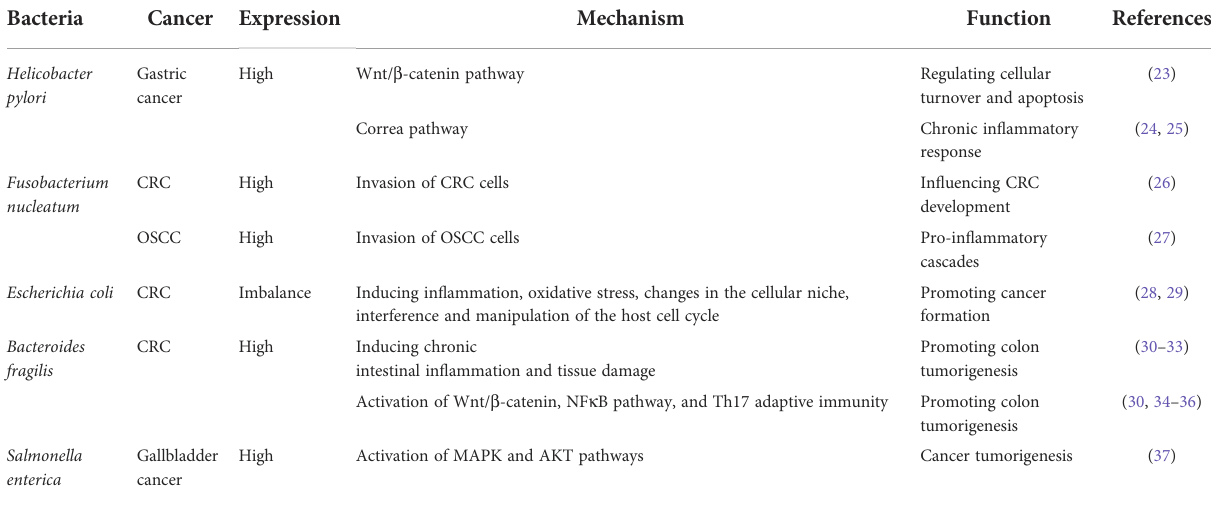
TABLE 1 Cancer-associated bacteria.